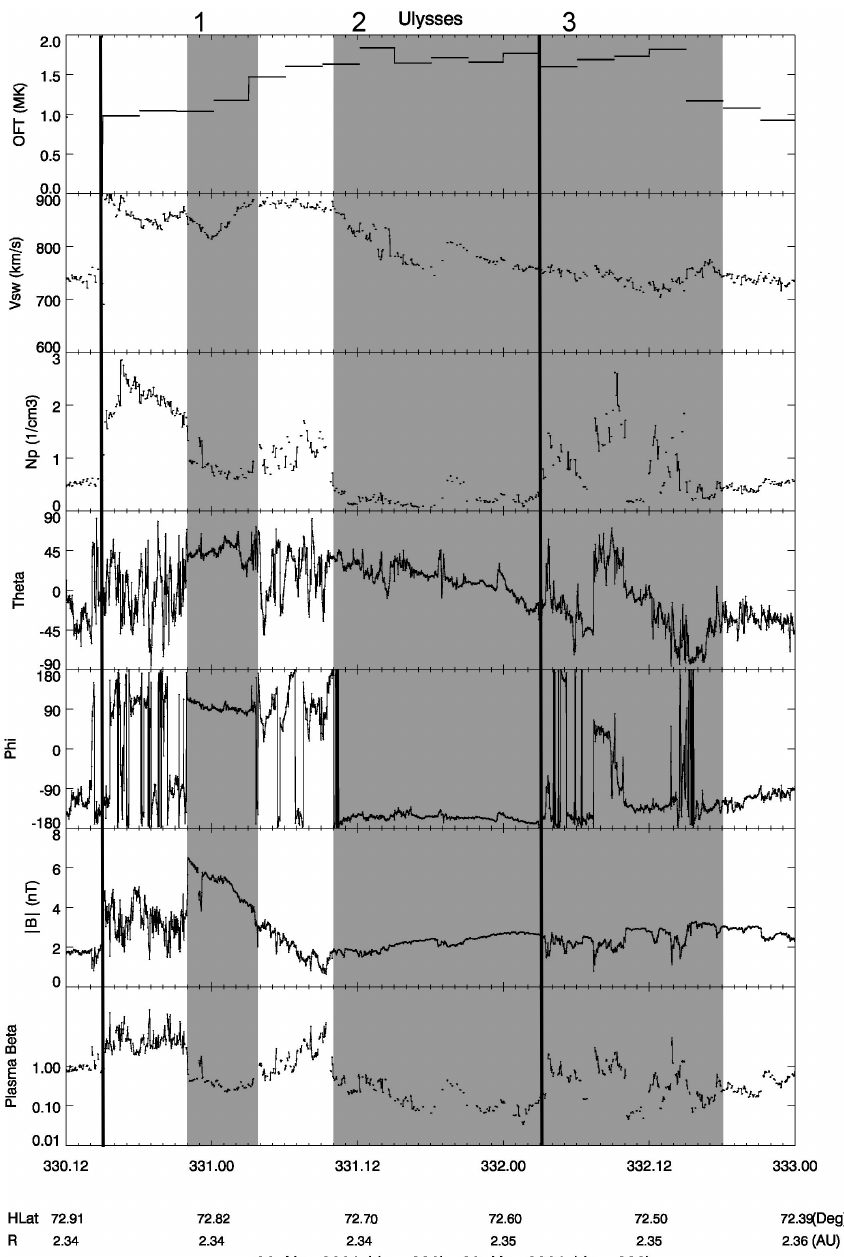
Fig. 7a. Ulysses measurements of the events in November 2001. The first vertical line marks the arrival of a shock. The first shading region shows an atypical region within the sheath. The second, bigger, shaded region represents the ejection, with the vertical line close to the middle separating a first part which shows MC characteristics from a second part which presents a non-cloud ICME